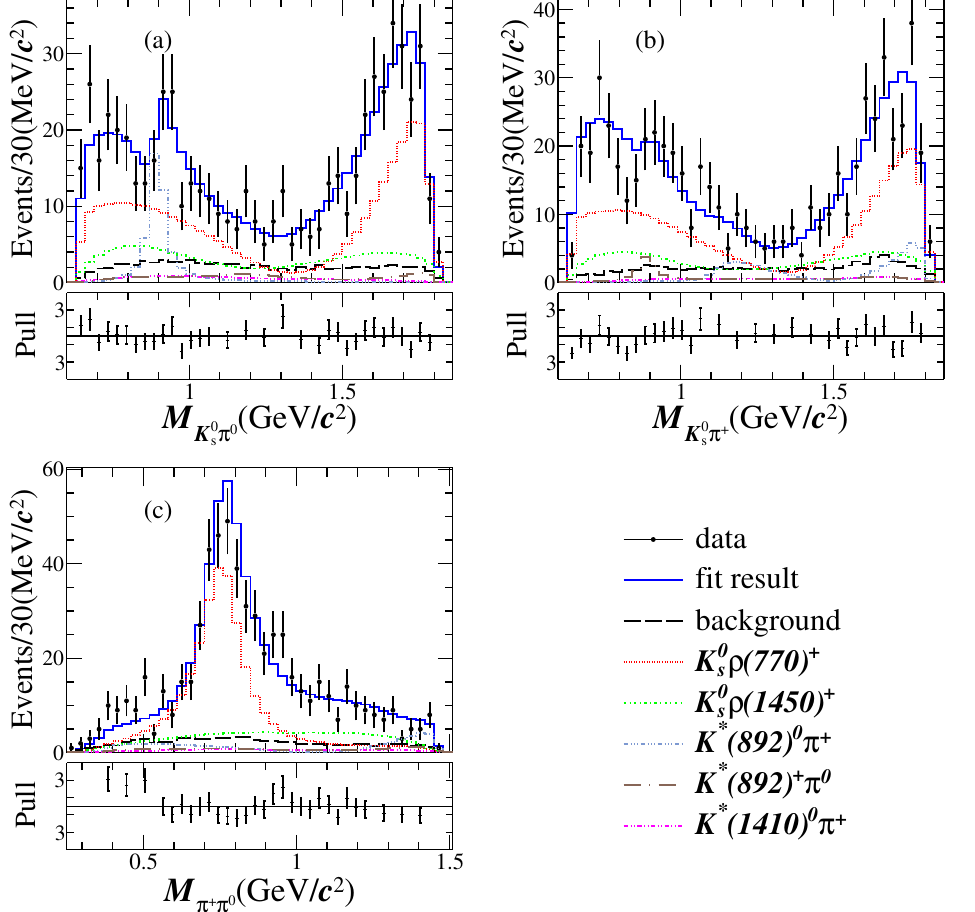
, (b) M , and (c) M from the nominal fit. The Figure 3 . The projections of (a) M π + π 0 K 0 π 0 K 0 π + √ S S data samples at s = 4 . 178 - 4 . 226 GeV are represented by points with error bars, the fit results by the solid blue lines, and the background estimated from generic MC samples by the black dashed lines. Colored curves show the components of the fit model. Due to interference effects, the total is not necessarily equal to the sum of the components. Pull projections are shown beneath each distribution, for which if there are less than 10 events in a certain bin, this bin is merged to the next bin until the number of events is larger than or equal to